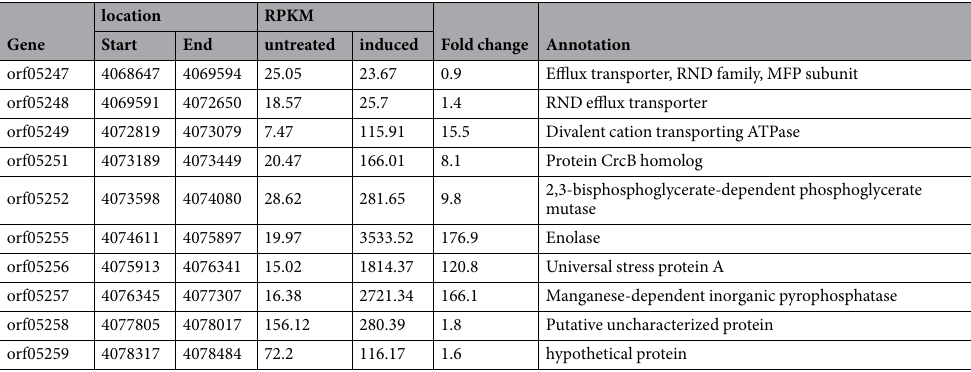
Table 1. Transcriptome annotation of the Enterobacter cloacae FRM genomic island